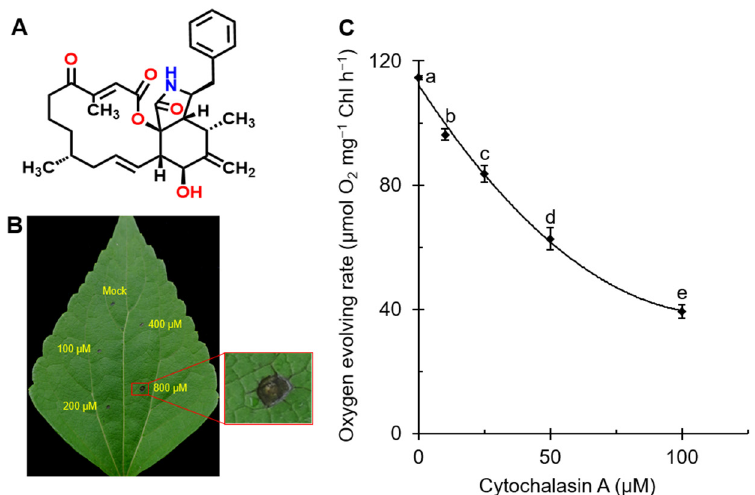
Figure 1. ( A ) Chemical structure of cytochalasin A (C 29 H 35 NO 5 , MW = 477.6). ( B ) Lesion formation of A. adenophora leaves treated with mock (10% acetone) and 100, 200, 400 and 800 μ M cytochalasin A. ( C ) Effect of cytochalasin A on oxygen evolving rate of C. reinhardtii cells. Data shown are mean values ± SE of three independent measurements with around 15 repetitions. The different lowercase letters (a,b,c,d,e) indicate to be statistical significance at 0.05 level.